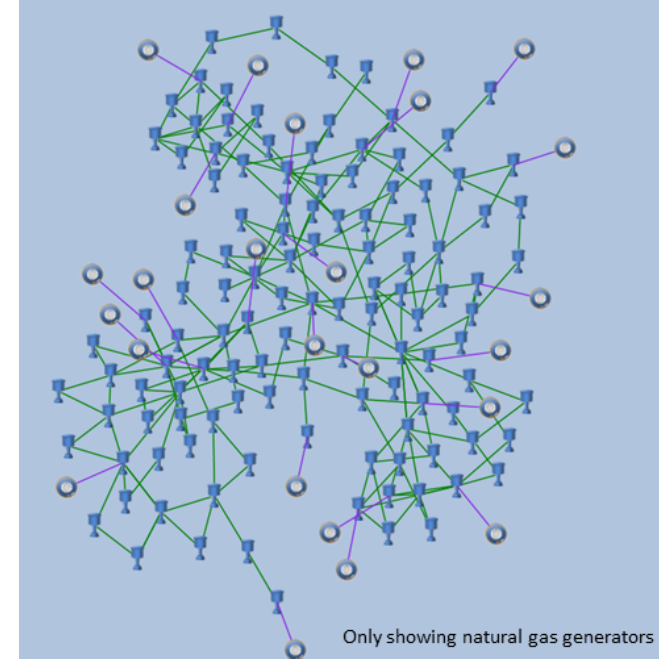
Figure 1. Topology of the IEEE 118-Bus power system